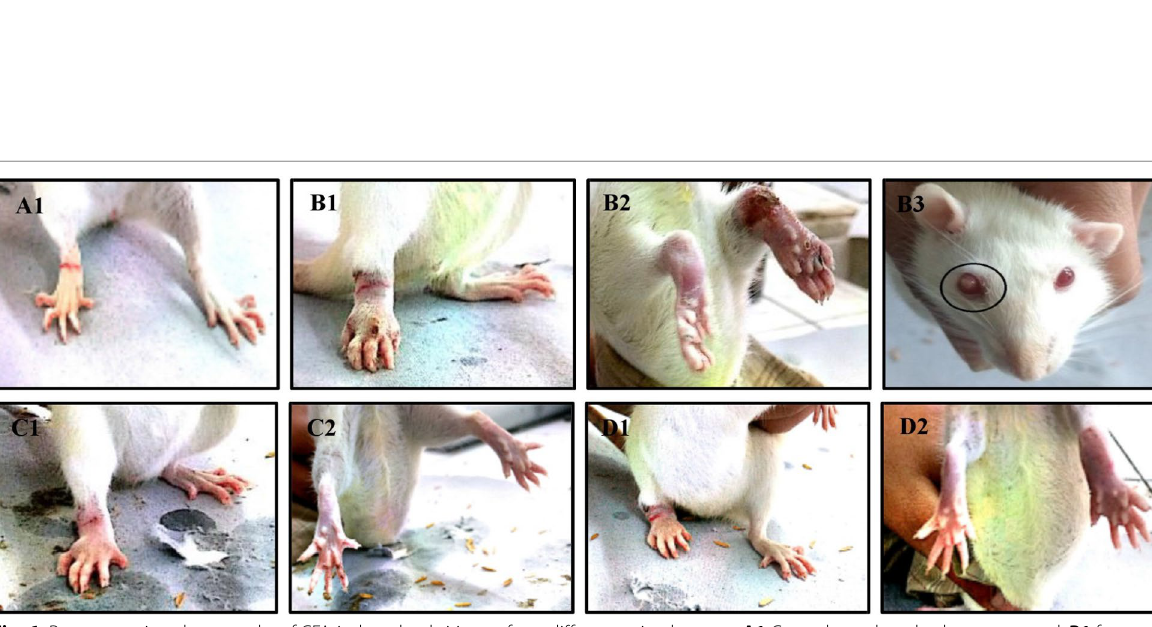
Fig. 6 Representative photographs of CFA-induced arthritic rats from different animal groups. A1 Control rats show both paws normal; B1 front view and B2 back view of left hind paw show severe inflammation, ulcer formation, pus formation and even deformities. B3 nodule in the eye (circle) indicates the extra-articular symptoms in CFA-induced arthritic rats; C1 front view and C2 back view of prednisolone-treated rats as well as ( D1 , D2 ) C . procera -treated rats show less inflammation and also no ulcer or pus